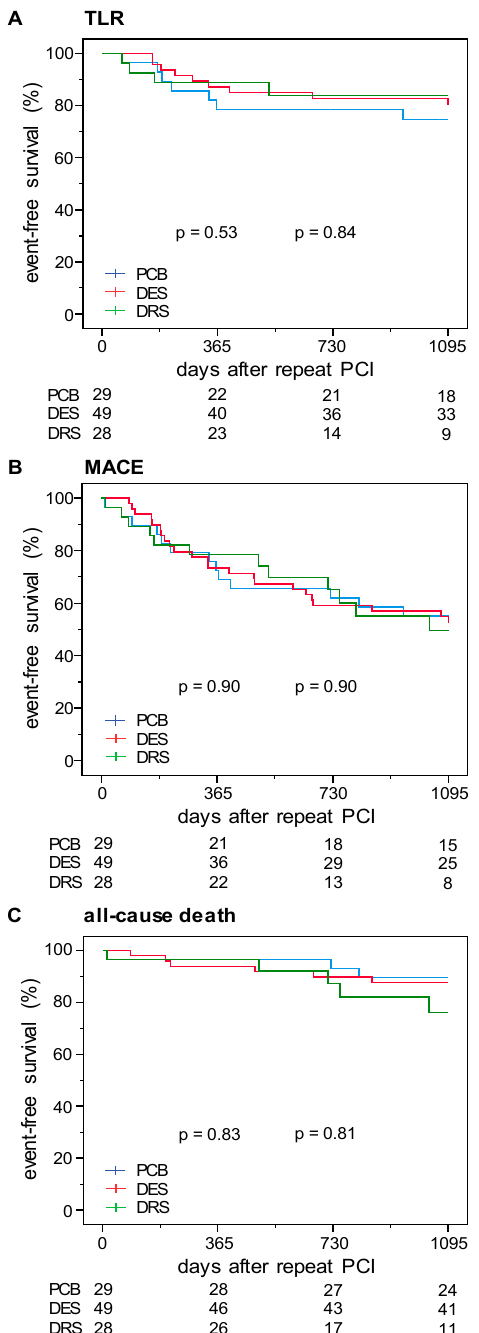
Figure 2. Kaplan–Meier estimates for cumulative event rates of ( A ) target lesion revascularization (TLR), ( B ) major adverse cardiac events (MACE), and ( C ) all-cause death in patients treated with paclitaxel-coated balloon (PCB, blue), drug-eluting stent (DES, red), or Dynamic Renal stent (DRS, green) treatment. p -value by log-rank test; PCI: percutaneous coronary intervention.